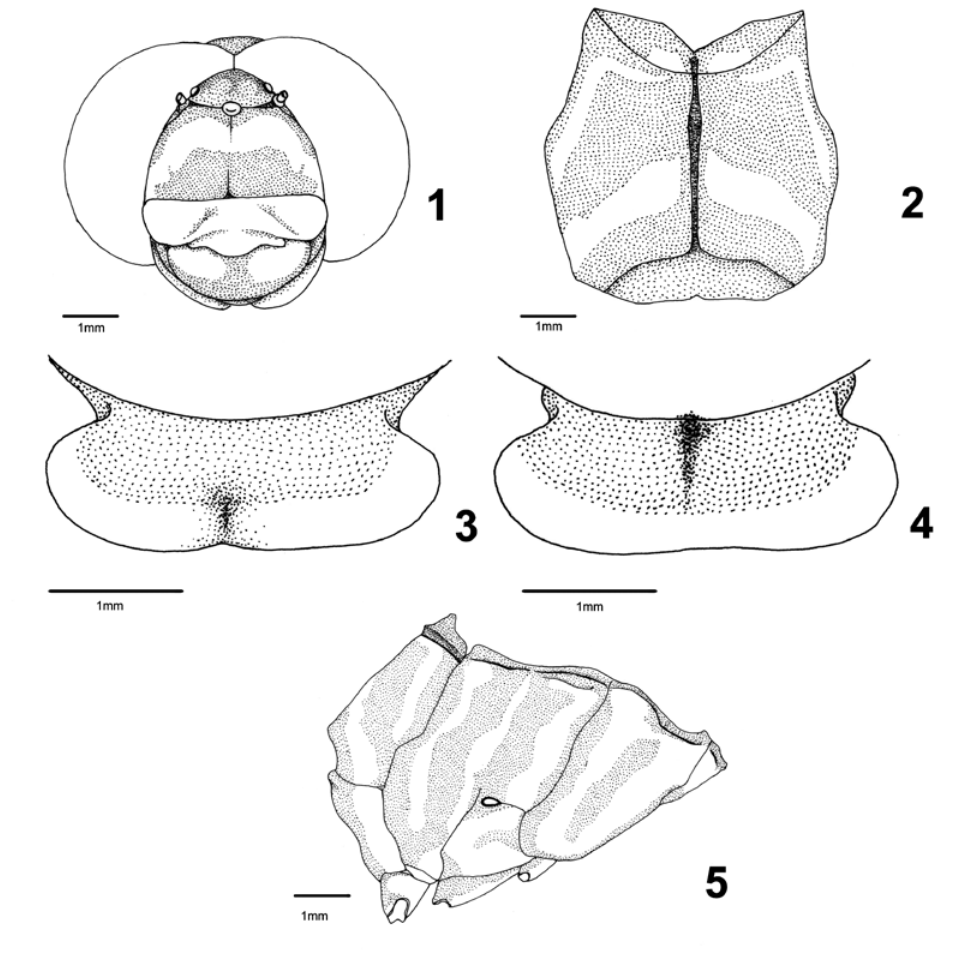
Figs. 1-5 - Carajathemis simone n. gen., n. sp. male holotype, head in frontal view (1) pterothorax in fronto-dorsal view (2) , hind prothoracic lobe in fronto-dorsal view (4) pterothorax in lateral view (5) . Female allotype hind prothoracic lobe in fronto-dorsal view (3) .